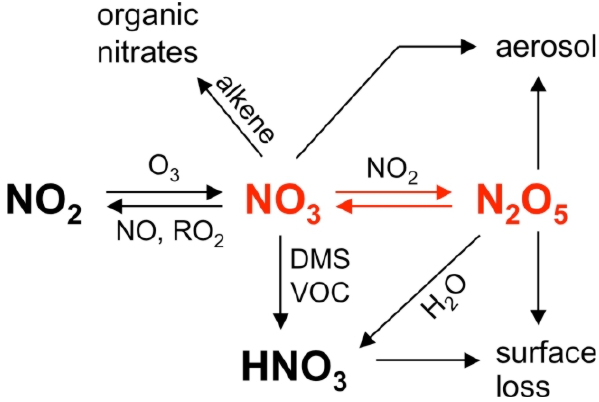
Fig. 1. Simplified schematic of nocturnal NO y chemical